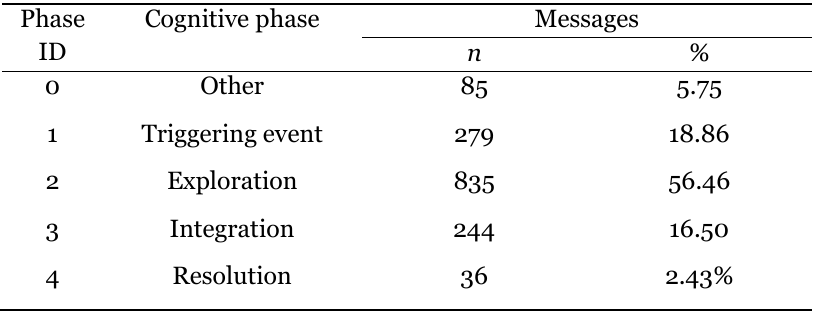
Messages of Agreements Between Three Coders by Cognitive